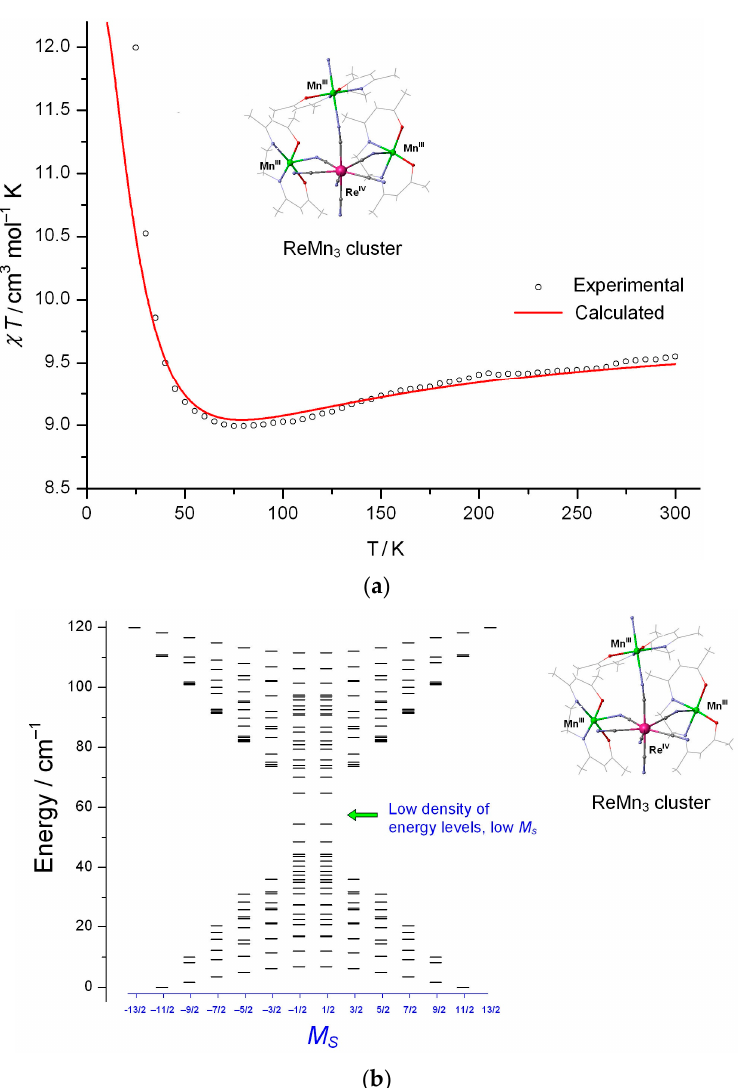
Figure 10. ( a )The experimental (circles) and simulated χ T curve for the isolated ReMn 3 cluster (red line) of 11 above T N = 13 K. Calculations were performed with J z = − 18, J xy = − 8 cm − 1 , J z = − 19, J xy = − 20 cm − 1 for the apical and equatorial pairs, respectively; D = − 4.0 cm − 1 , E = 0 (ZFS parameters for Mn III ions), g z = 3.66 and g x = g y = 1.59 for [Re(CN) 7 ] 3 − , and g Mn = 2.03 [44]. ( b ). Calculated spin-energy spectrum of the ReMn 3 cluster. Low density of energy levels in the middle range of the energy spectrum (represented by spin states with a low M s projection) is responsible for a flat minimum in the χ T curve. Reproduced with permission from ref. [44]. © 2022 American Chemical Society.